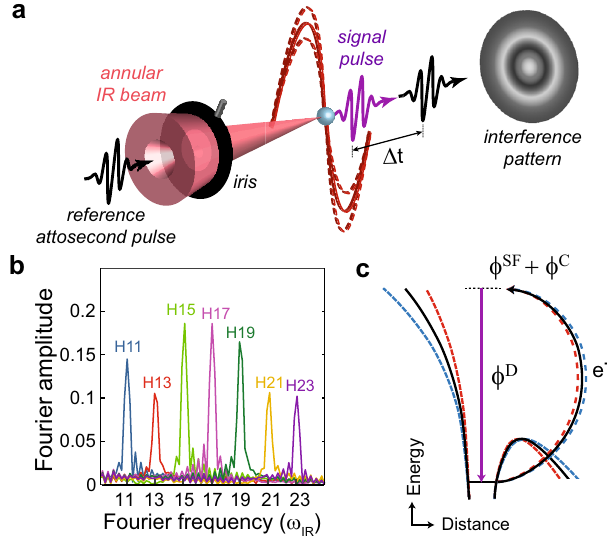
Figure 1. Differential phase measurement using XUV-XUV interferometry. (a) Experimental scheme. A delay controlled APT (black) and its generating annular IR pulse (red) are focused into a gas target, where a second phase-locked and independent APT (purple) is generated by the same IR pulse. The interference signal between the two APTs as a function of delay is spectrally resolved and recorded in the far-field for a range of IR intensities, controlled by a motorized iris. (b) Fourier amplitudes of an interference signal extracted from a delay scan where argon is used in both sources. Harmonics 11 to 23 oscillate at their fundamental frequency. (c) Schematic description of the phase accumulated during the HHG process. The phase of the emitted XUV photon encodes all the steps of the HHG interaction: strong-field tunneling and acceleration φ SF and the dipole transition phase φ D at recollision. In addition, the electron accumulates phase φ C as it interacts with the ionic Coulomb potential. Changing the IR intensity leads to a variation of the electron trajectory, as indicated by the red and blue lines for higher and lower intensity, respectively. As a result, both φ SF and φ C are modified, while φ D remains